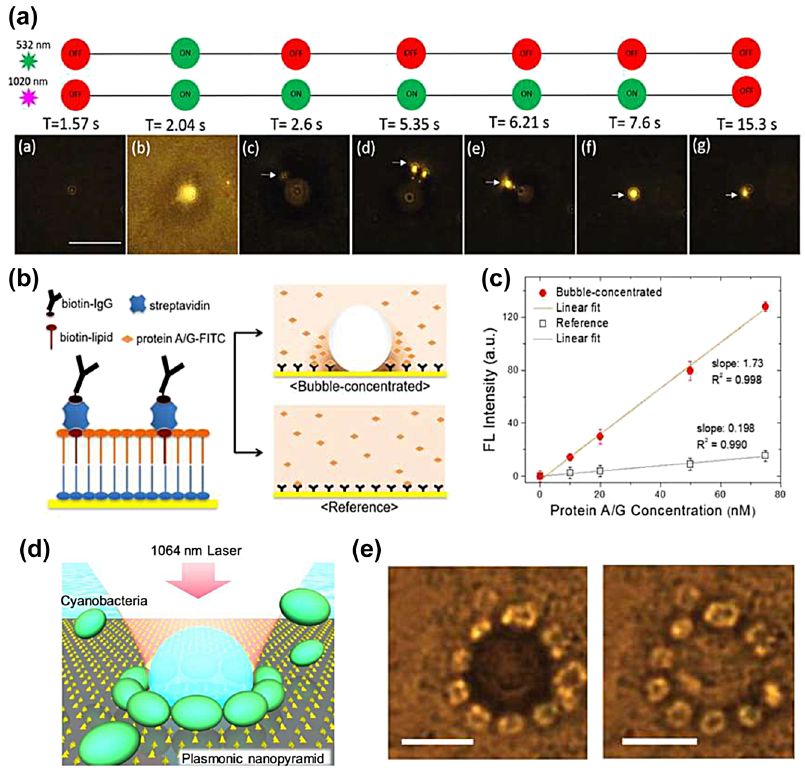
Figure 7: Marangoni-assisted trapping